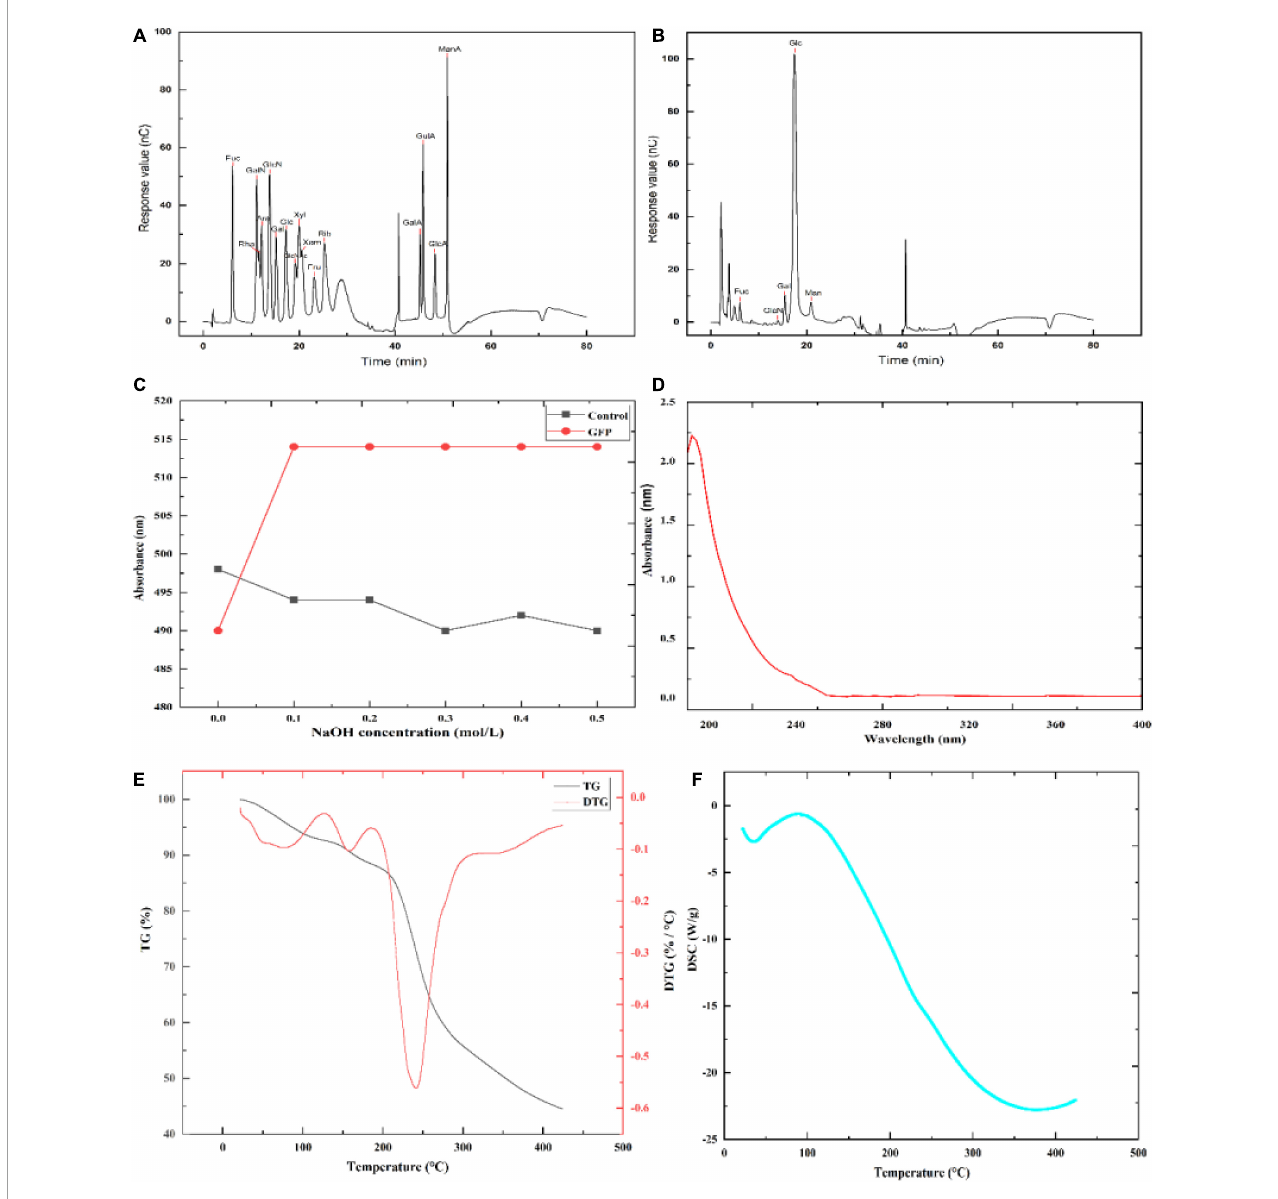
FIGURE4 Partial structural analysis of GFP: (A) Ion chromatograms of 16 monosaccharide standards; (B) ion chromatograms of monosaccharides in GFP; (C) Congo red experimental result of GFP; (D) UV scan result of GFP; and (E,F) TG-DSC comprehensive thermal analysis results of GFP.